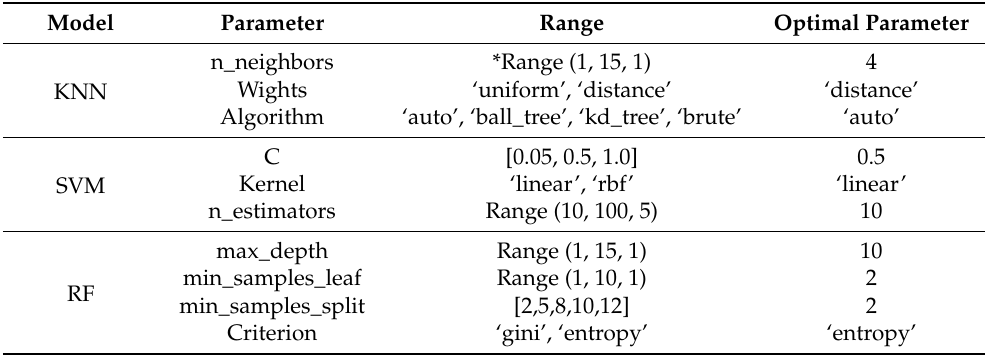
Table 8. Results of hyperparameter optimization using grid search and five-fold